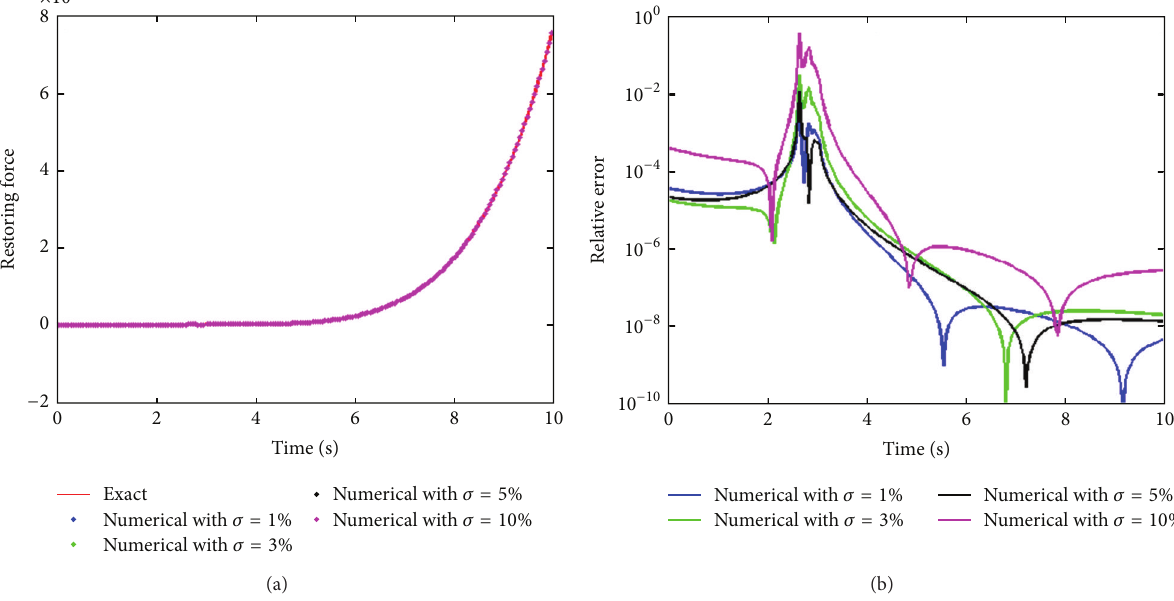
Figure 5: For Example 1, (a) comparing estimated and exact restoring forces under different noise level and (b) displaying the error of estimation with 𝜎 = 1 %, 3%, 5%, and 10%, respectively.